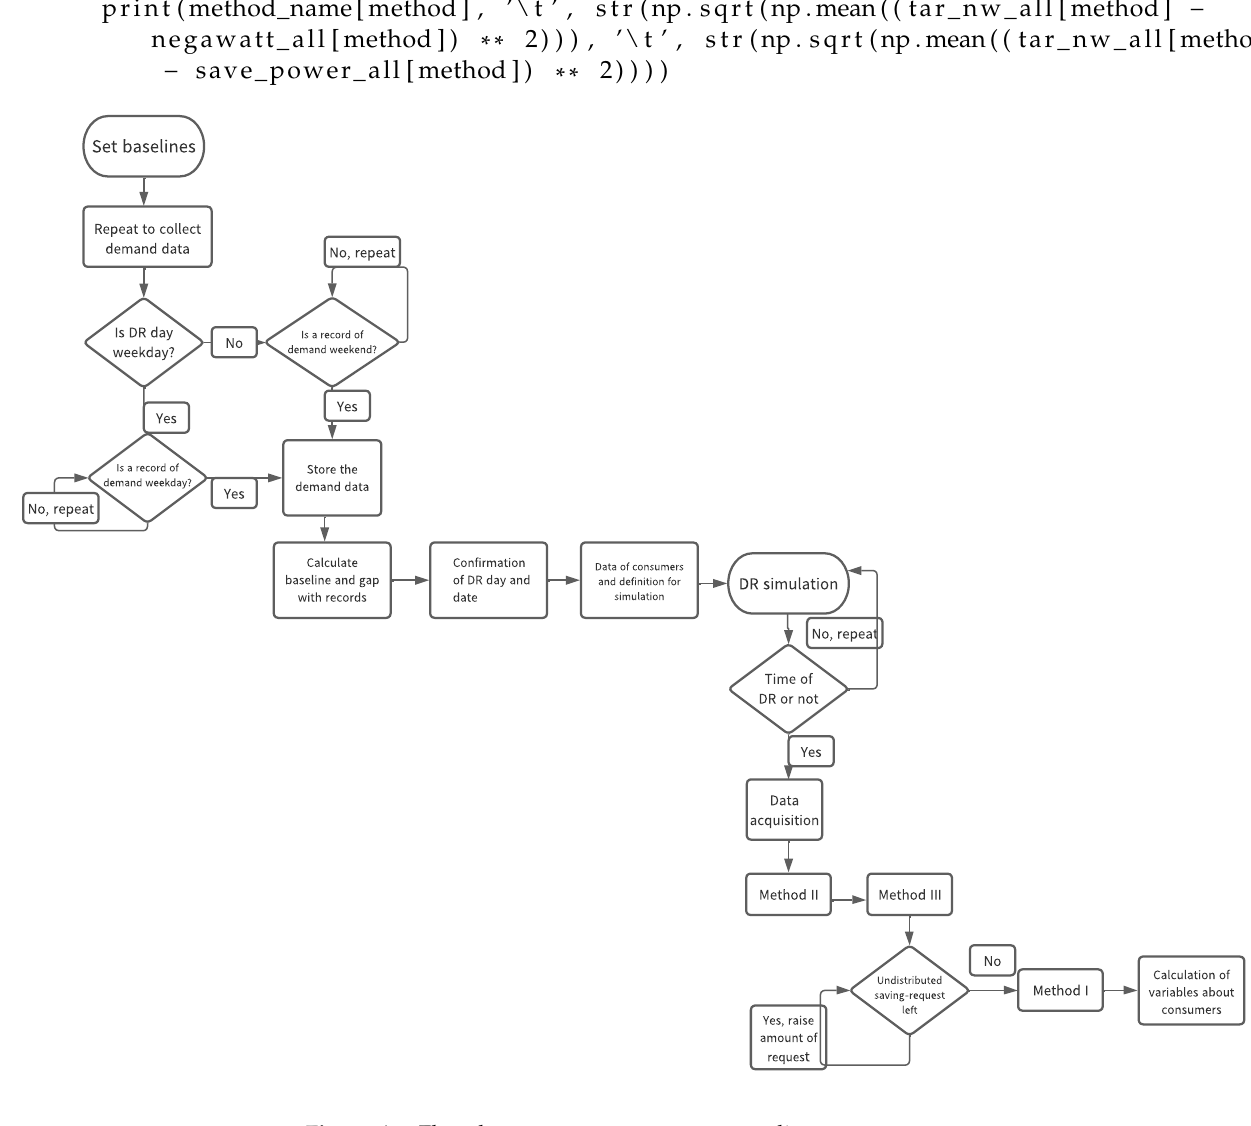
Figure A2. Flowchart to carry out negawatt